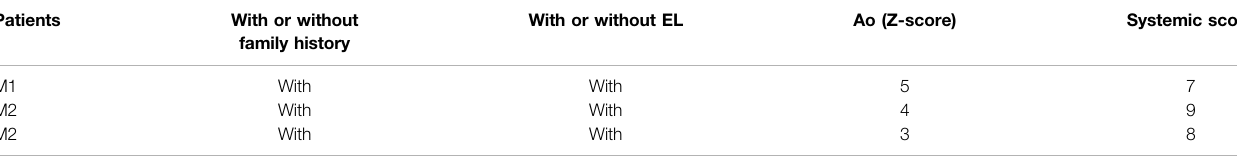
TABLE 1 | The diagnosis of Marfan syndrome (M) relies on de fi ned clinical criteria (Ghent nosology). Patients With or without With or without EL Ao (Z-score) family history M1 With With With With With With